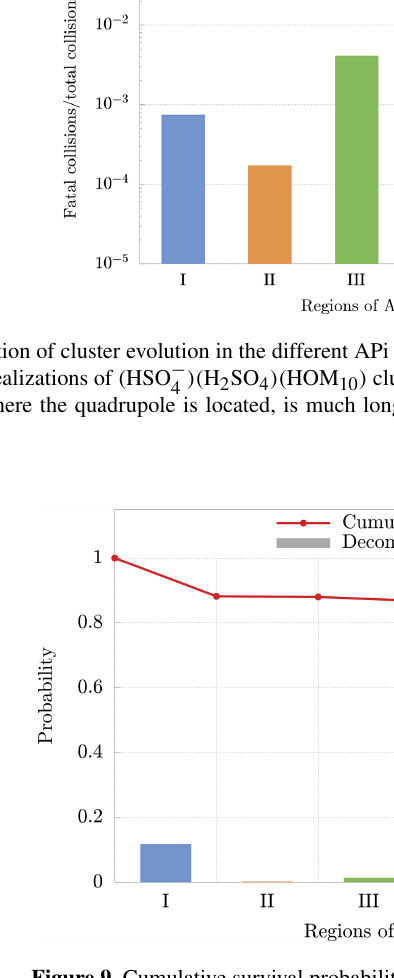
Figure 9. Cumulative survival probability after going through each region (red dots) and decomposition probability (bars) for a sin- gle cluster realization. The decomposition probability in each re- gion is given by the ratio of clusters decomposing inside the re- gion, over clusters entering the region. The results are relative to )( H 2 SO 4 )( HOM 10 ) the ( HSO − 4